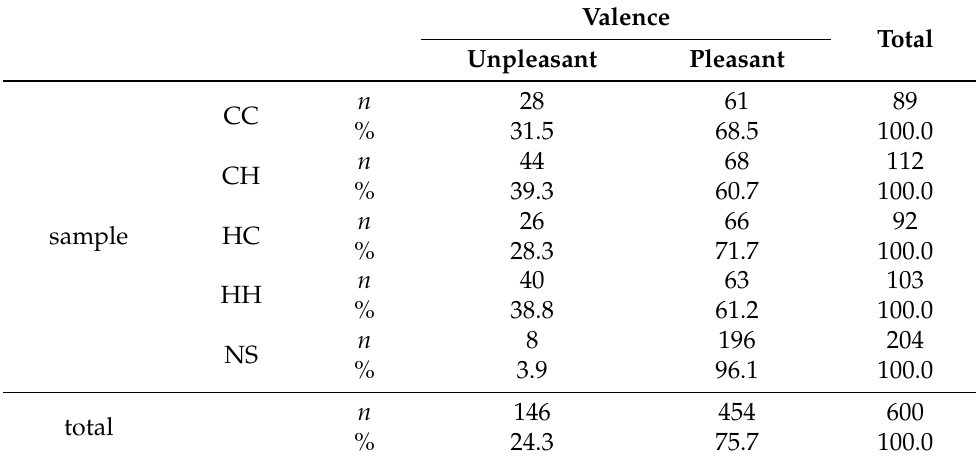
Table 7. Contingency table audio sample,